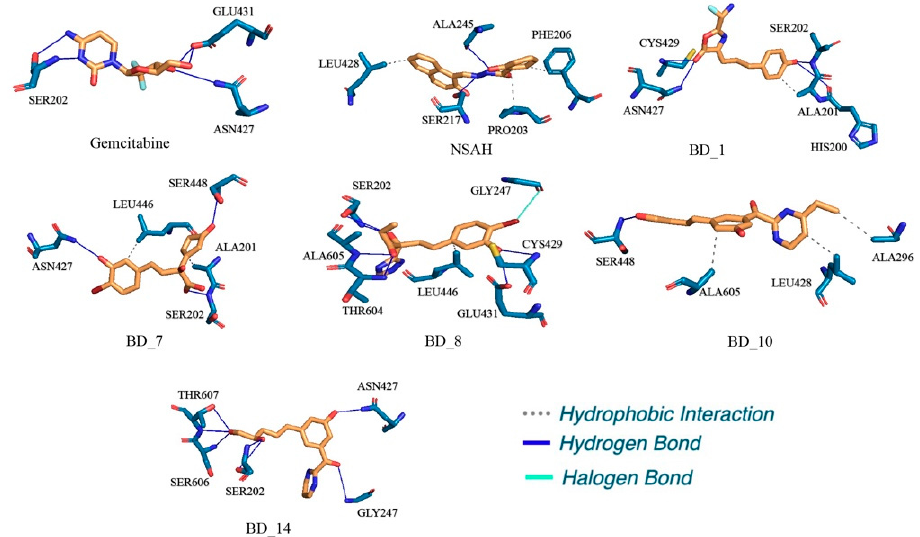
Figure 12. Post-MD simulation binding interactions profile of identified hRRM1 inhibitors–modulators at 100 ns.